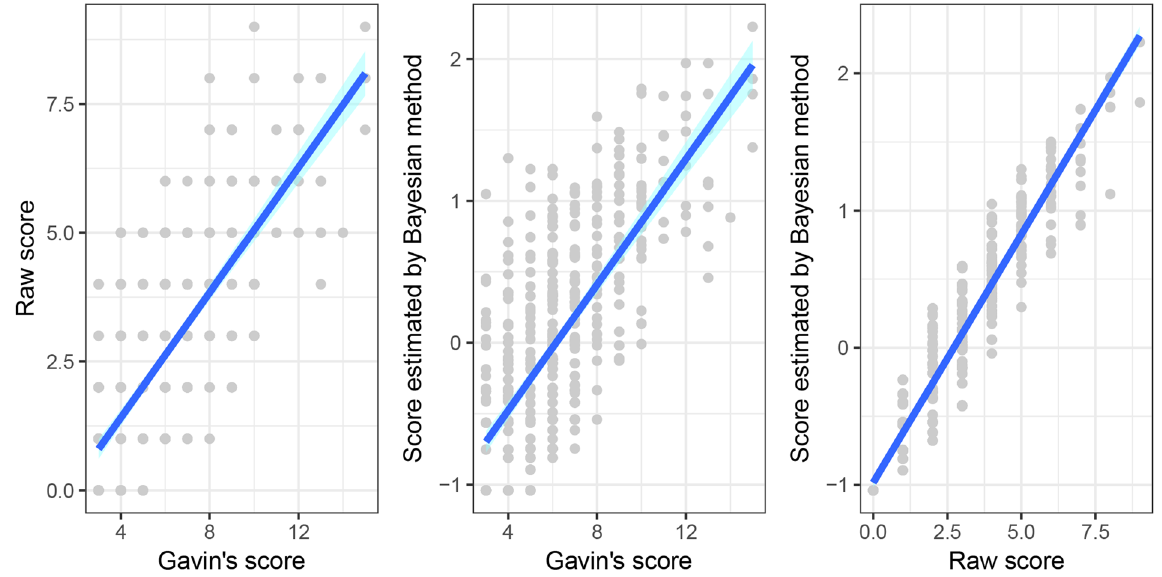
Figure 2. Scatter plots for Gavin’s score, raw score and the Bayesian estimates of ability. Gavin’s score was highly associated with both raw test score (Pearson’s r = 0.76) and Bayesian score (Pearson’s r = 0.73). Bayesian score was the Bayesian estimates of patients’ ability (namely the risk of developing diabetic foot); their posterior standard deviations served as standard errors. Bayesian score obeys Gaussian distribution with mean = 0 and standard deviation = 1.